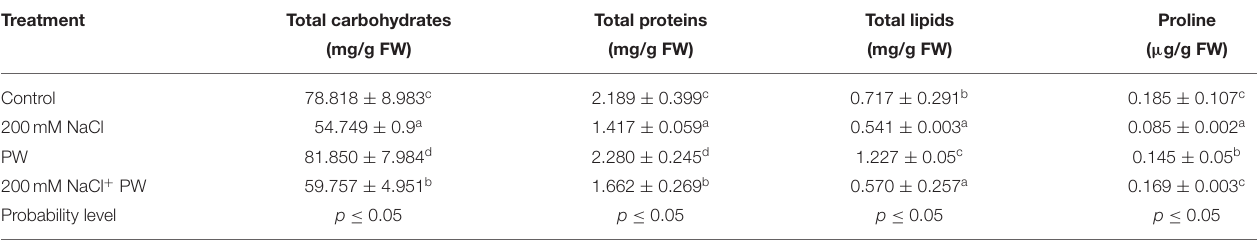
TABLE 2 | Effect of S. lycopersici (PW) on total carbohydrates, total proteins, total lipids, and proline content of maize plants under salt stress.